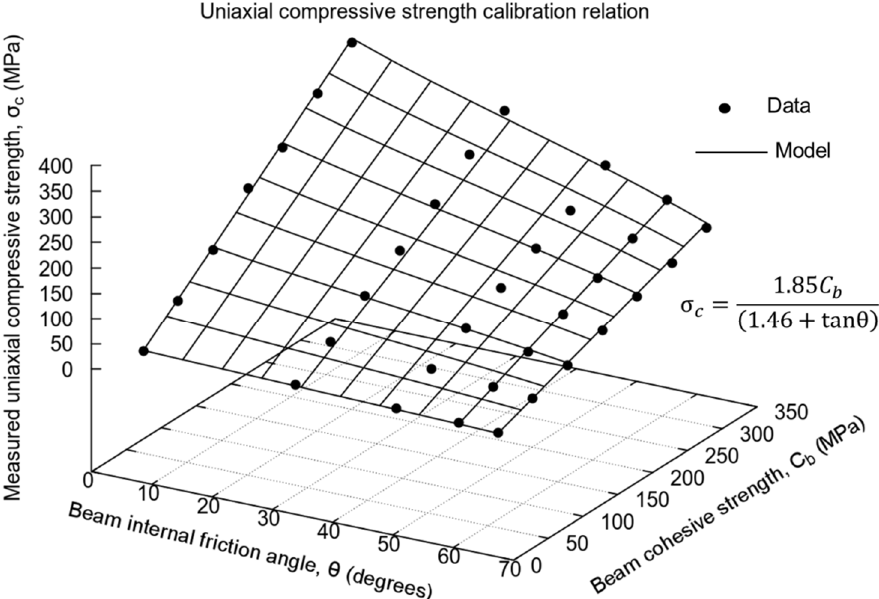
Figure A7. Surface dot-plot and model fit of calibration relationship between measured Young’s modulus at different elastic beam modulus and beam Poisson’s ratio.